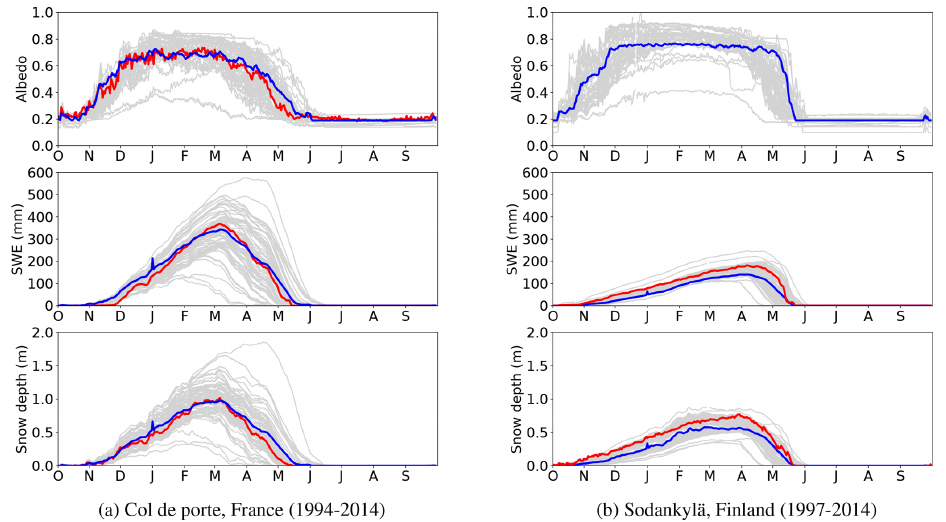
Figure 5. Comparison of long-term daily mean COSIPY with ESM-SnowMIP simulations for two sites. COSIPY simulations (blue lines), measurements (red lines), and ESM-SnowMIP (grey lines) simulations of albedo, snow water equivalent (SWE), and snow depth at two sites. Measurements and simulations provided by Krinner et al.